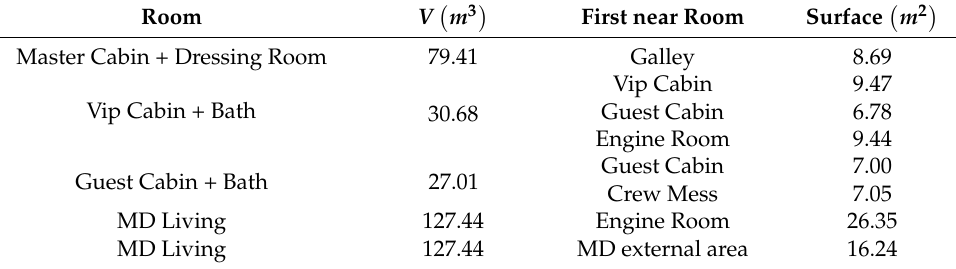
Table 1. Values of the volume and area of the separating elements under